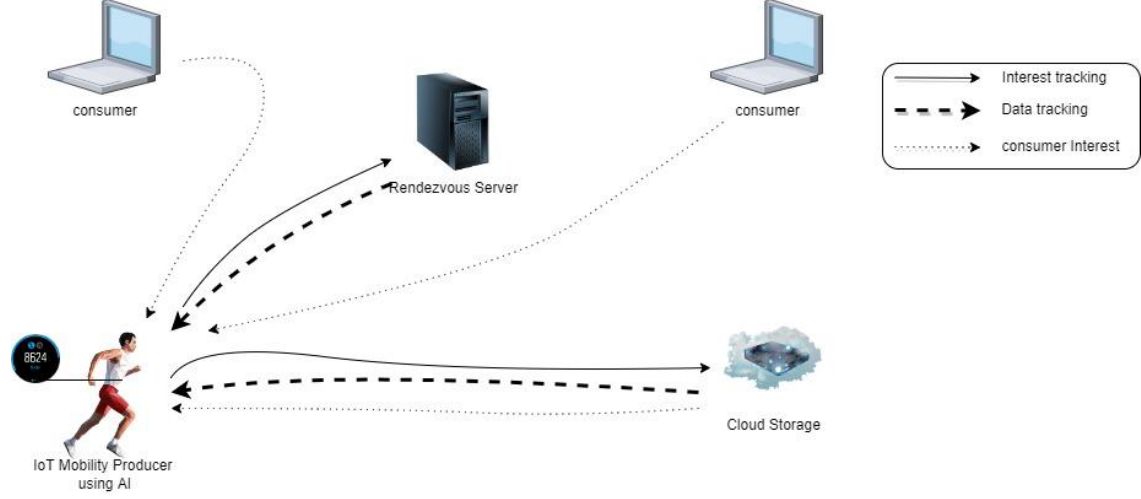
Figure 5. KITE operation with cloud storage. Table 2. KITE operation.